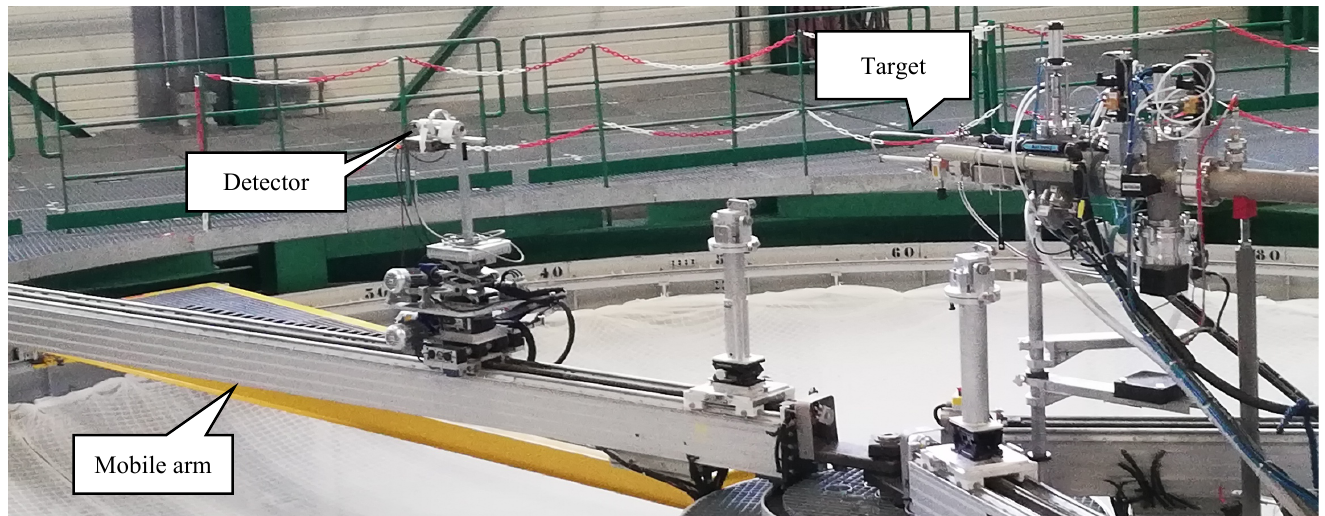
Figure 1 Experimental area with the stilbene detector mounted on the mobile